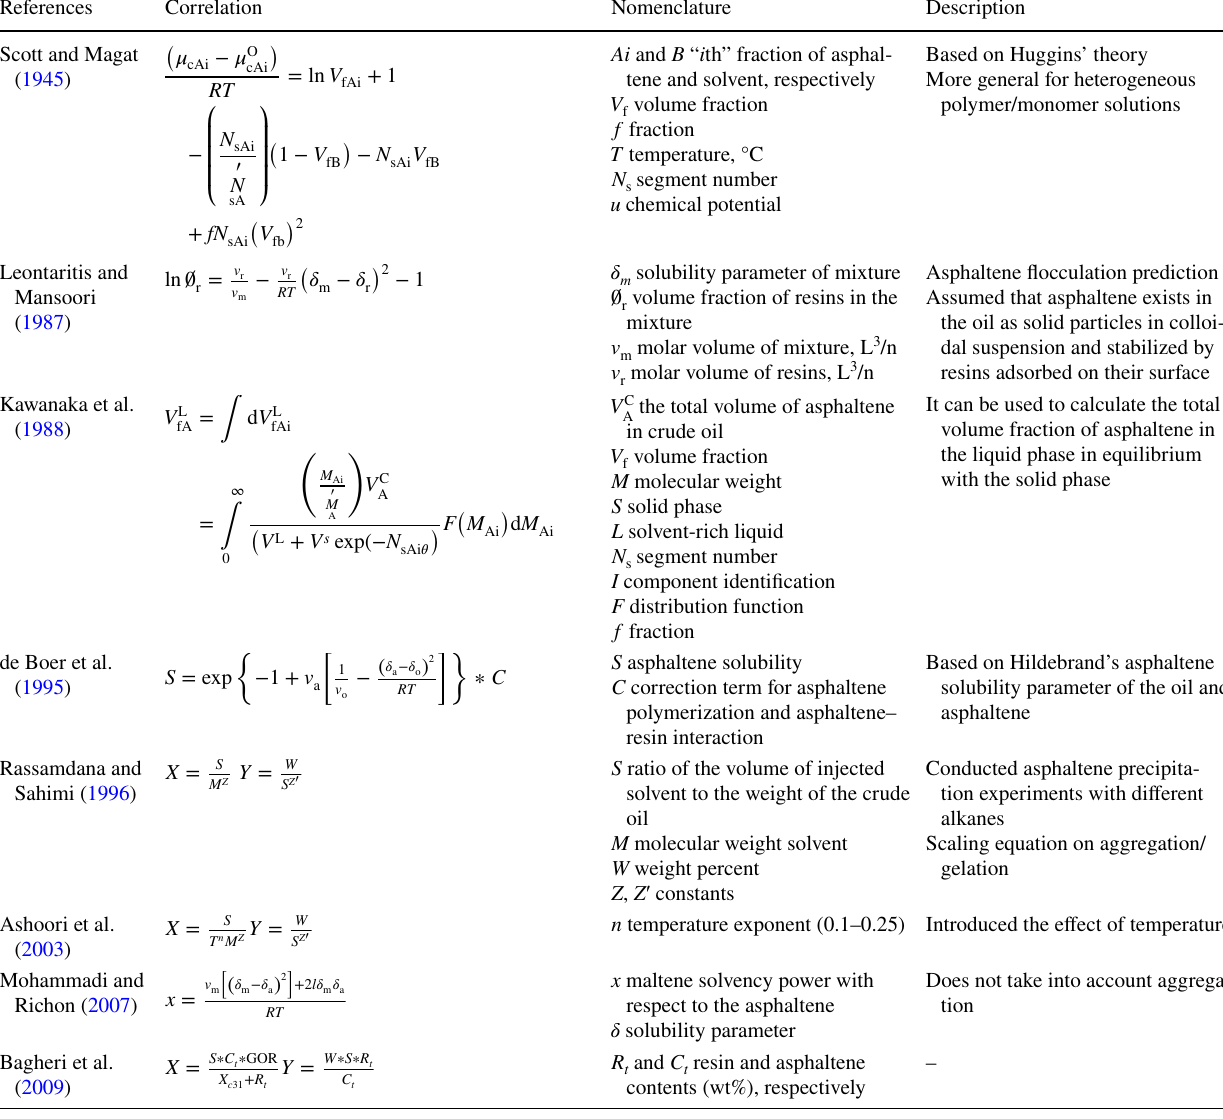
Table 5 Correlations predicting asphaltene properties